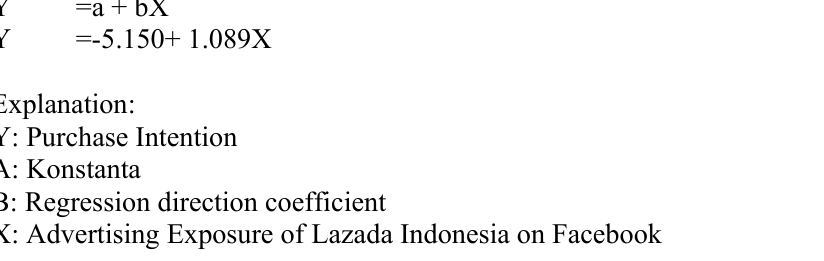
Regression Equation Model Model Unstandardized Coefficients Standardized Coef-